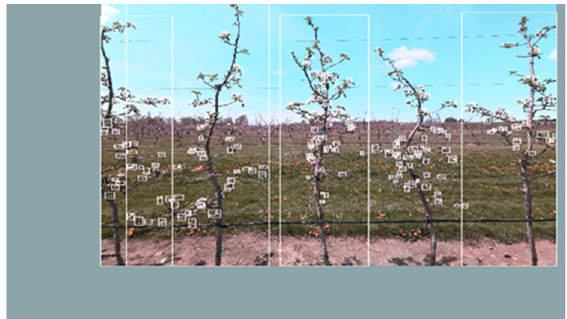
Figure 8. Example of zero padding on an image.